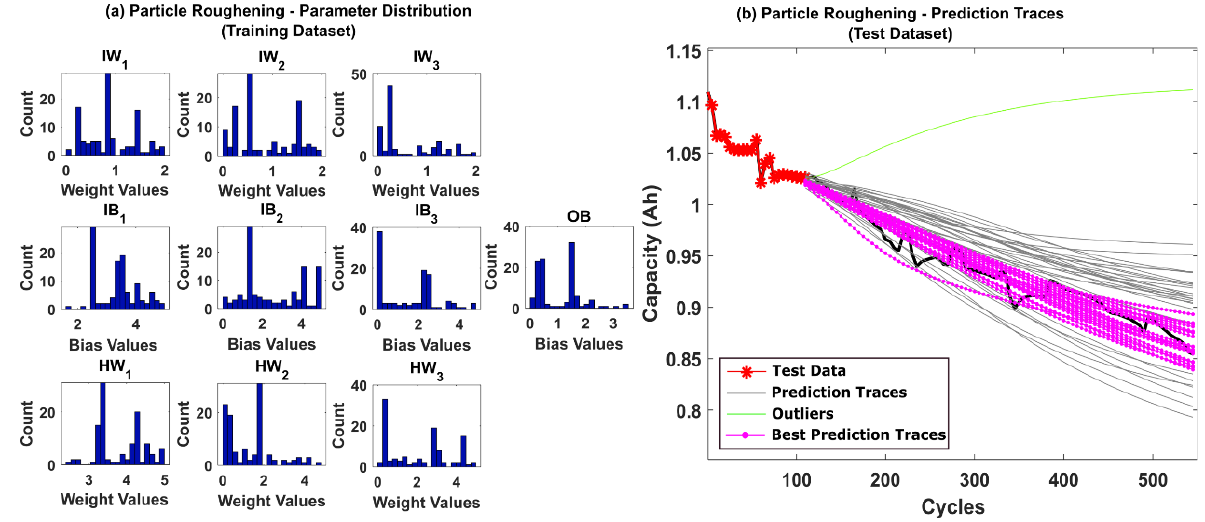
Figure 10. ( a ) The posterior distribution of MLP network parameters estimated by the adaptive Bayesian learning framework using particle roughening and ( b ) the degradation prediction traces for CALCE battery (CS-37) using particle roughening. The prediction traces for 50 repetitions are shown using the gray lines, the green lines represent outliers, and the magenta lines represent the traces with minimum RMSE values.